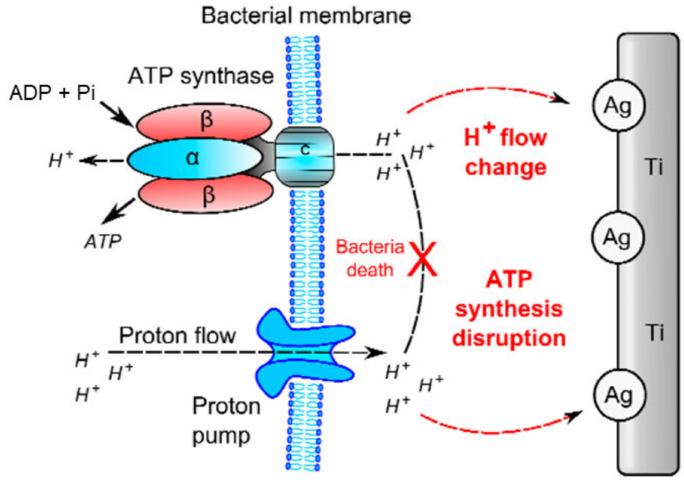
Figure 7. Schematic diagram of the sterilization mechanism of antibacterial surface materials repre- sented by silver ions